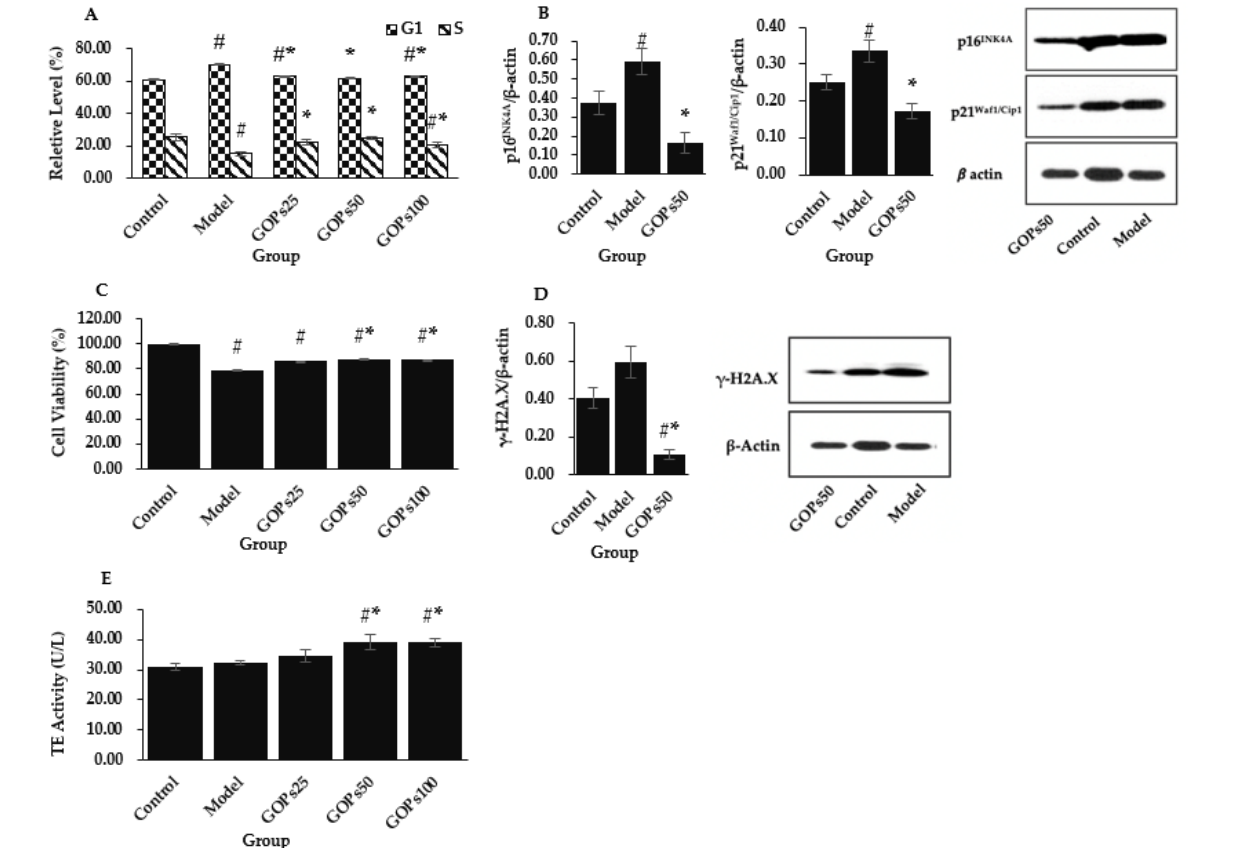
Figure 1. Effect of ginseng oligopeptides (GOPs) on the hallmarks of senescence in NIH/3T3. ( A ) Effect of GOPs on the cell cycle distribution of the NIH/3T3 cells ( n = 3 per group). ( B ) Effect of GOPs on the relative protein expression of p16 INK4A and p21 Waf1/Cip1 ( n = 3 per group). ( C ) Cell viability evaluation of GOPs using the CCK-8 assay ( n = 4 per group). ( D ) Effect of GOPs on DNA damage ( n = 3 per group). ( E ) Effect of GOPs on telomerase (TE) activity ( n = 3 per group). Values represented the mean ± S.D. # p < 0.05 versus control group, * p < 0.05 versus model group.